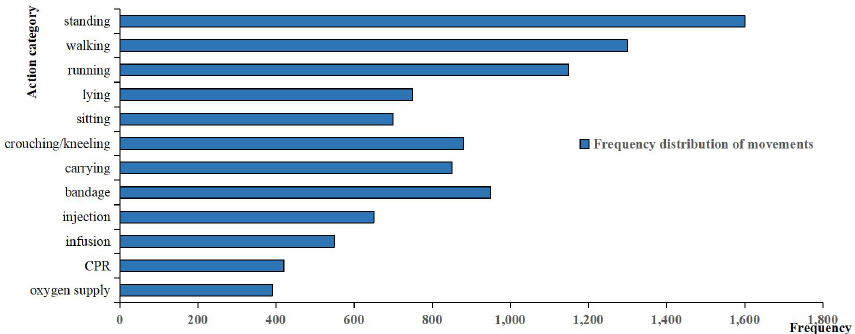
Figure 10. Action category frequency distribution in the self-built